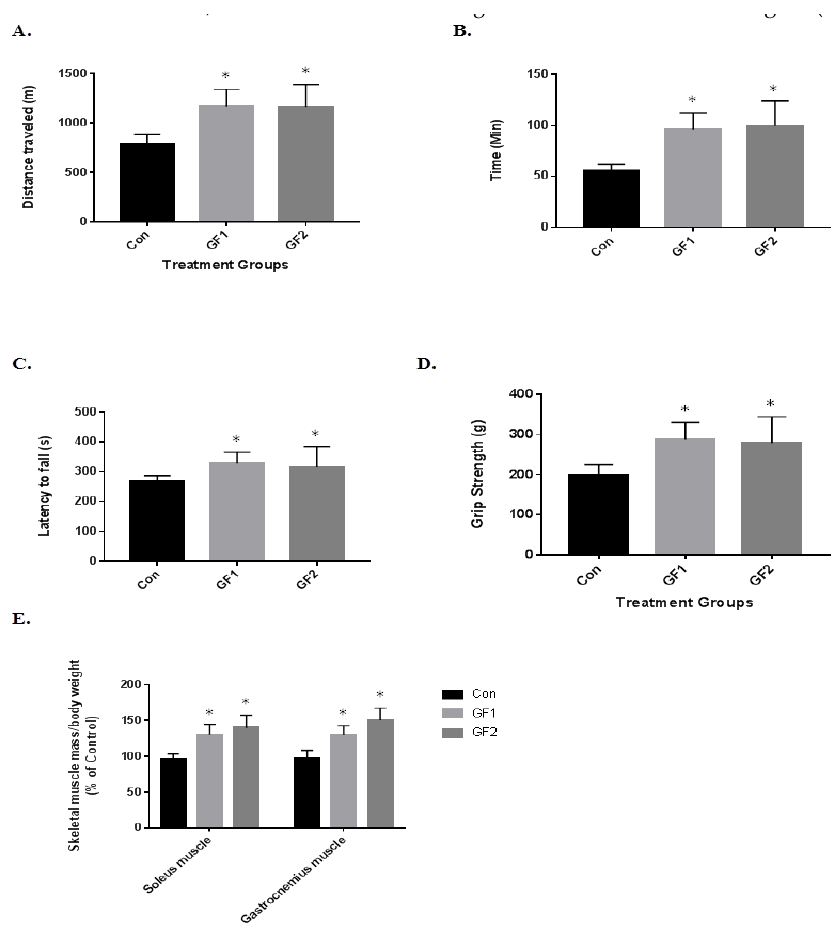
Figure 2. Effects of GF diets on exercise endurance and skeletal muscle mass in C57BL/6 mice. ( A ) Running distance and ( B ) time of normal mice and mice that were fed a normal diet enriched with GF supplements. ( C ) Time to fall in a rotarod test ( D ) grip strength and ( E ) the ratio of skeletal muscle mass (soleus and gastrocnemius muscle)/body weight in normal and GF supplemented mice. Data are expressed as the mean ± SD ( n = 10 per group), * p < 0.01 compared to control